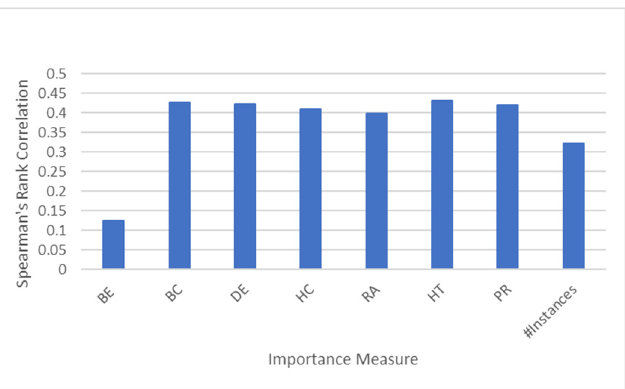
Table 5. Characteristics of the KGs used for experimental evaluation.